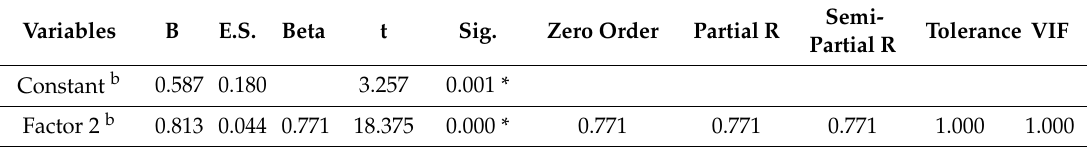
Table 5. Linear regression of the development of mathematical thinking a in early childhood education with the use of video games.